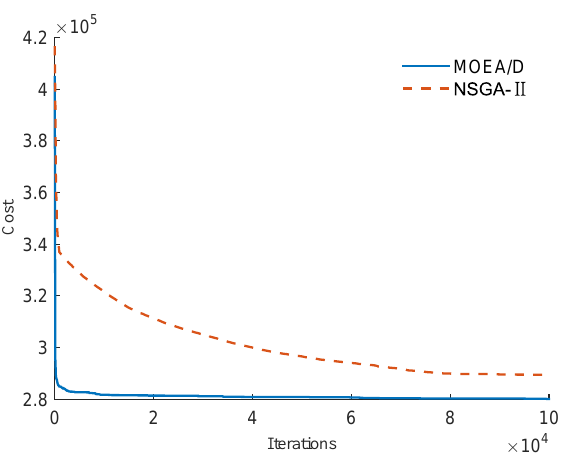
Figure 9. Convergence property of emission function with MOEA/D and NSGA ‐ II.